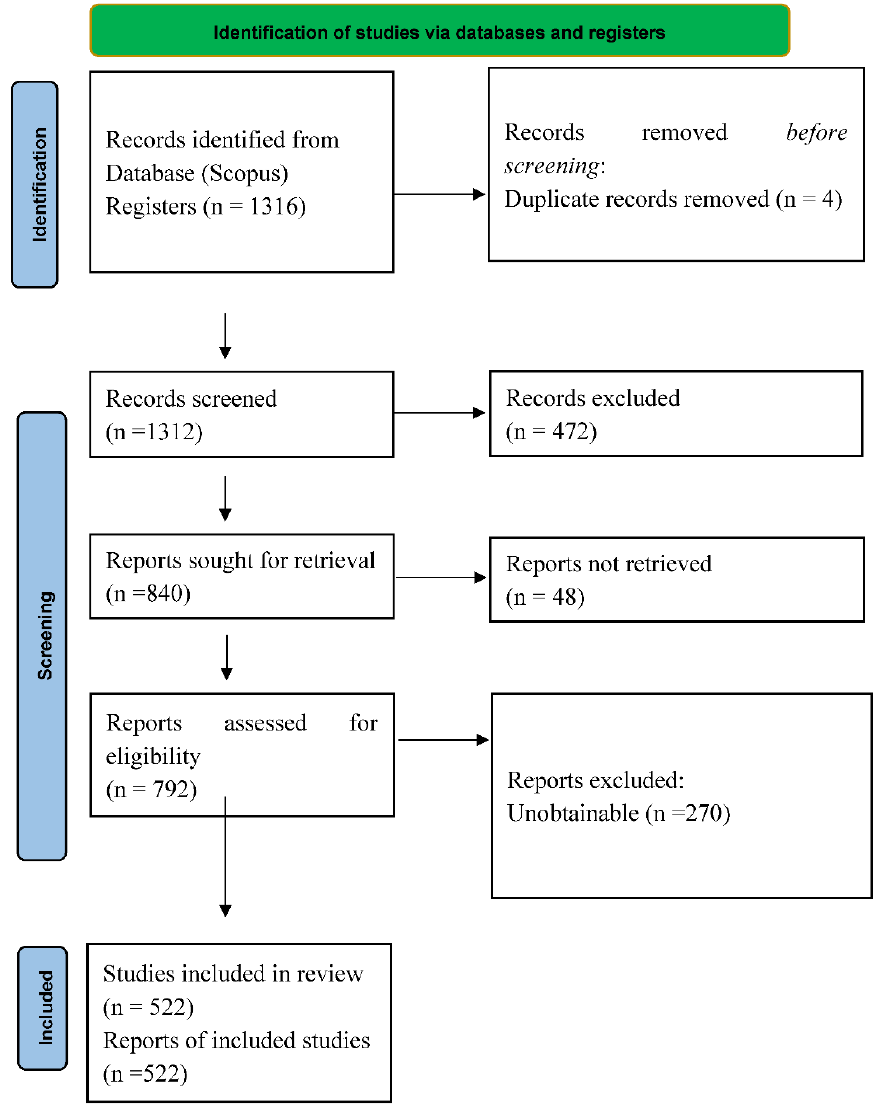
Figure 1. Study selection process flowchart.